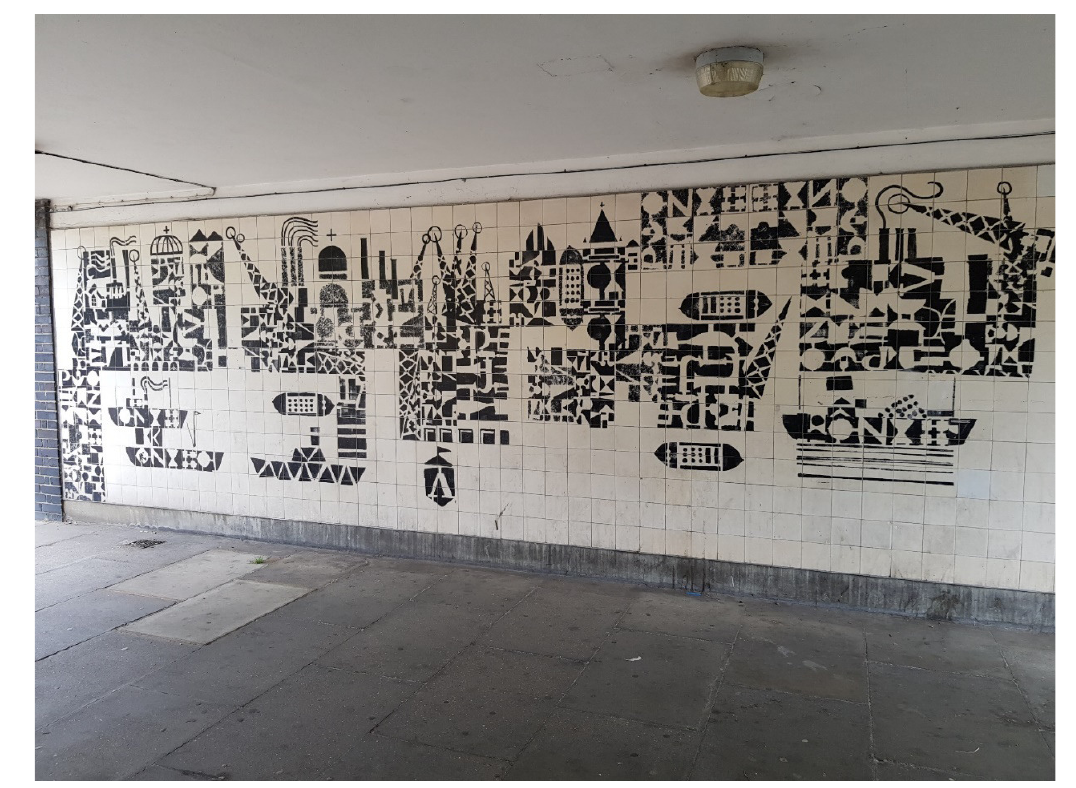
Figure 3. Anthony Hollaway with Oliver Cox’s Docklands mural, Gorsefield House, Birchfield Estate,